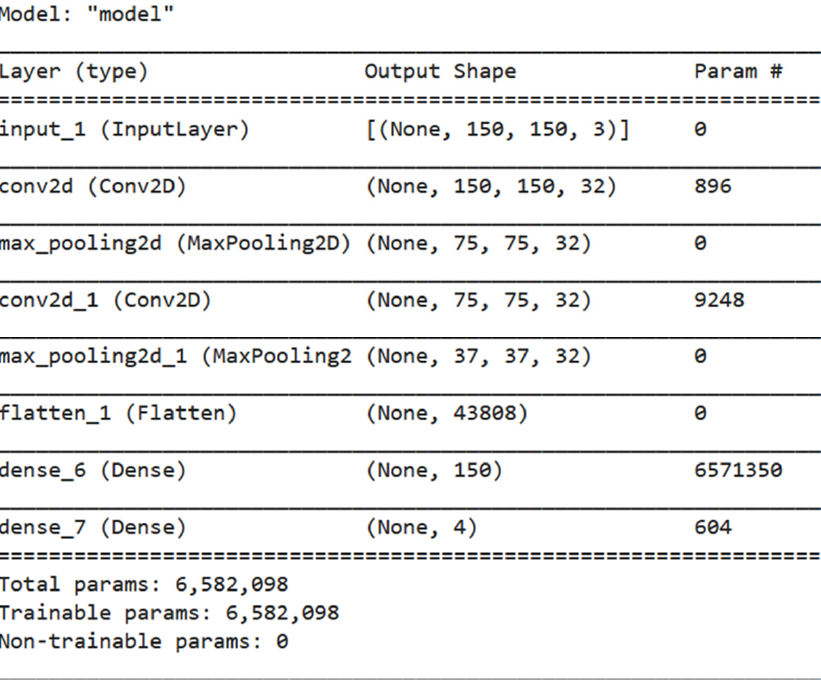
Figure 7. Summary of the proposed model for multi-classification.